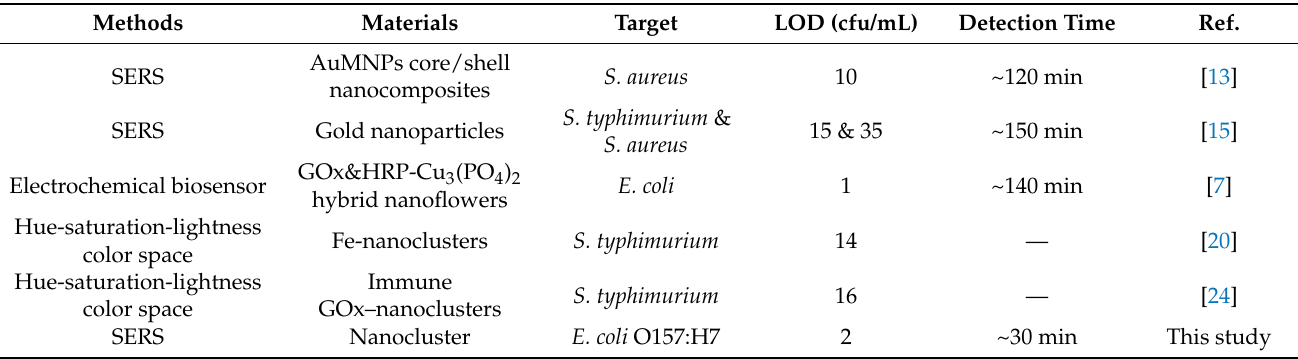
Table 2. Comparison of the detection method, target pathogens, limit of detection (LOD), and detection time of this study with related detection material in other